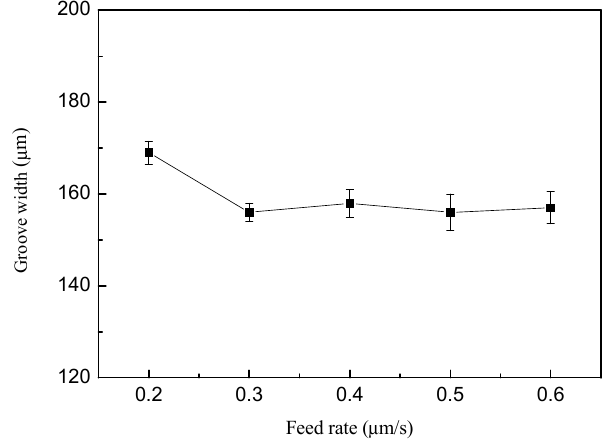
Figure 13. Curve of groove width with the feed rate.